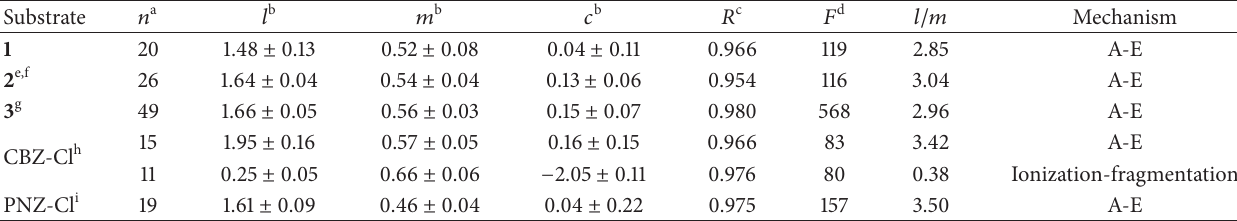
Table 2: Correlations of the specific rates of solvolysis of 1–3 , CBZ-Cl, and PNZ-Cl using the extended Grunwald-Winstein equation (2). Substrate